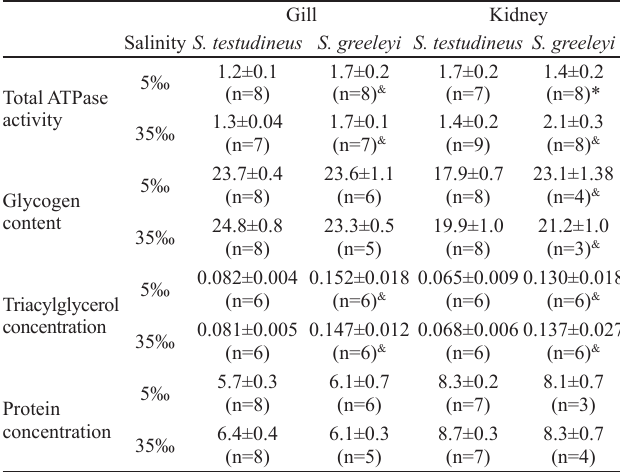
Table 2. Total ATPase activity ( m molPi.mgProt/h -1 ), triac- ylglycerol (mg.Triac/mg.Prot) and glycogen content ( m mol glycosyl units/g), and protein concentration (mg/mL) of bran - chial and renal tissues of S. testudineus and S. greeleyi after short-term exposure to seawater of 5‰ or 35‰ salinity, mean ± standard error. * = salinity effect (5‰ ≠ 35‰), p<0.05; &